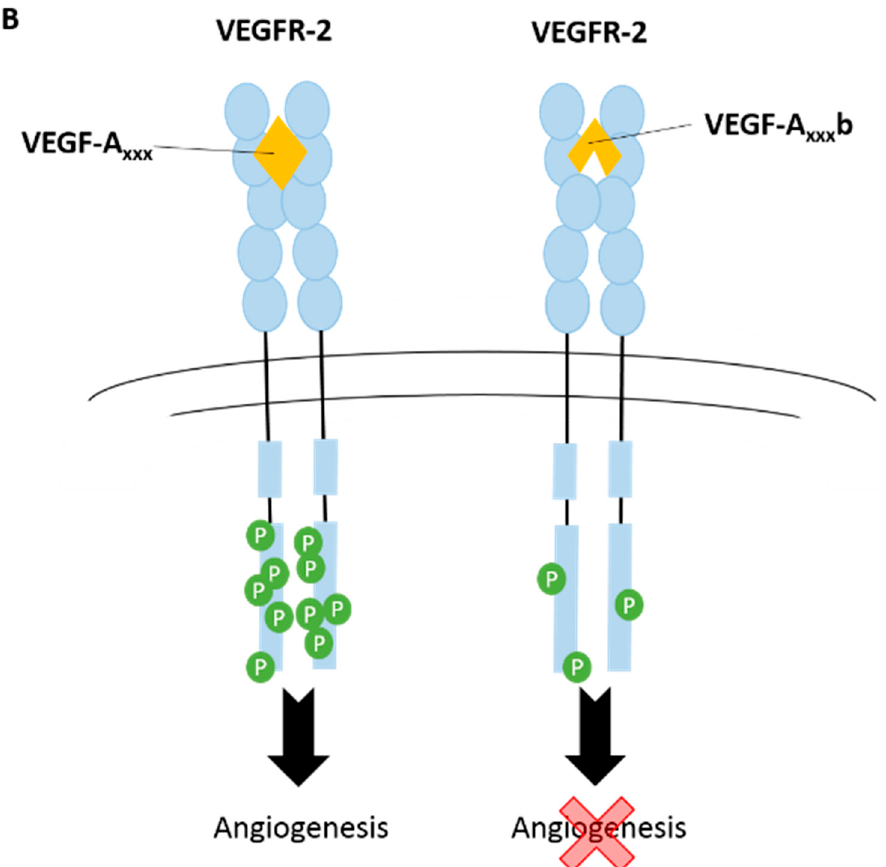
Figure 3. Alternative splicing of tyrosine kinase receptors and ligands that modulate angiogenesis. ( A ) Tyrosine kinase receptors: VEGFR-2 (with NRP-1 co-receptor), FGFRs and Tie-2 are shown with corresponding major ligands: VEGF-A, FGF-2, Ang-1, respectively. The number of currently known isoforms is indicated. ( B ) The effect of canonical VEGF-A xxx and alternatively spliced VEGF-A xxx b on the activation of the VEGFR-2 receptor and downstream signalling cascade leading to angiogenesis. Canonical VEGF is proangiogenic, whereas VEGF-A xxx b acts a partial agonist of the receptor and does not induce angiogenesis.